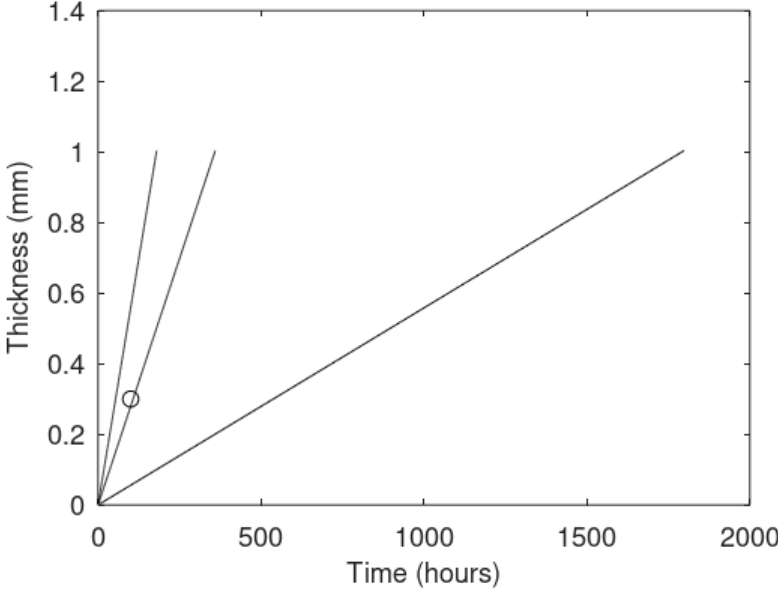
Figure 21. Calculated induction times (solid curves) as compared to first observation of visible hydrate in an experiments without induced hydrodynamics (o) [64,66]. The liquid side of interface diffusivities are, from left to right; 1.0 × 10 − 7 m 2 /s, 5.0 × 10 − 8 m 2 /s and 1.0 × 10 − 8 m 2 /s.